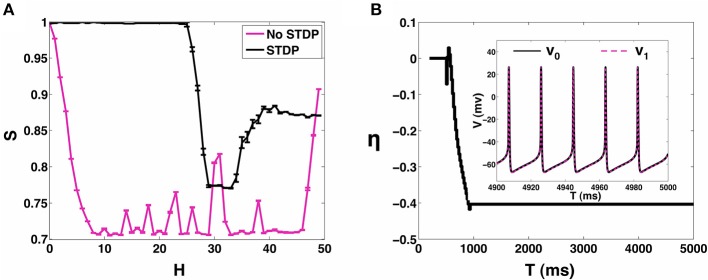
2-MCI Synchrony metric. (A) A measure of the synchrony metric when STDP is enabled (black) and without STDP (magenta) for the range 0 ≤ H ≤ 50. (B) Shows the evolution of η for an example initial case of {η0 = 0, H = 10}. In the inset we show the corresponding voltage traces of the neurons after reaching in-phase synchronization.